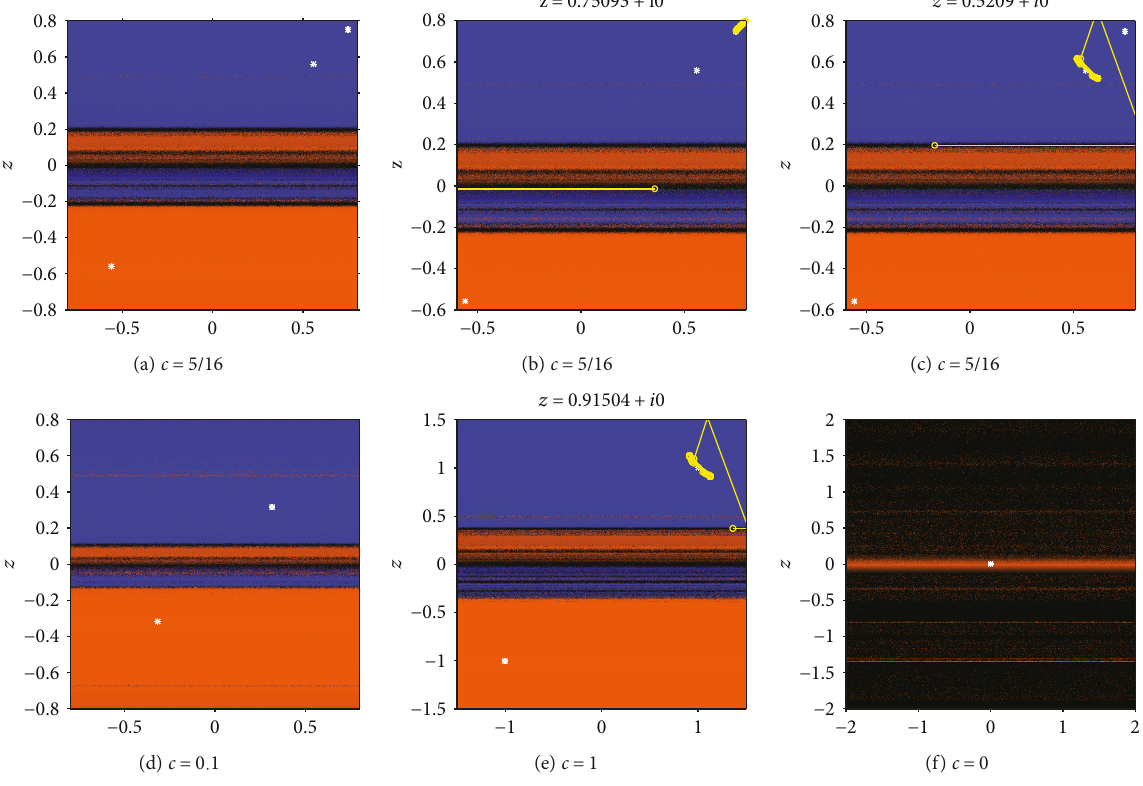
of M s c , s c , s c , s c , c , i = 1, 2 . i i i i i